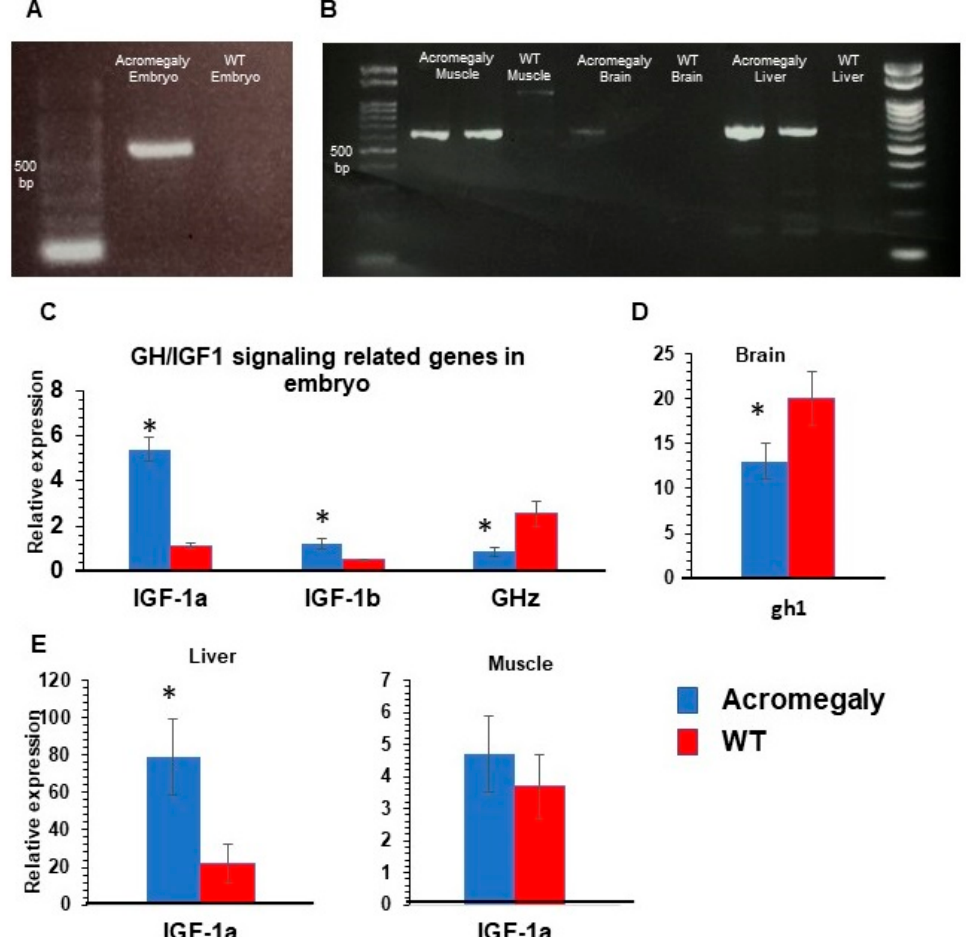
Figure 2. GH/IGF1 signaling ‐ related gene expression in Acromegaly zebrafish. ( A , B ) RT ‐ PCR showing tilapia GH gene expression in acromegaly zebrafish larvae (3 dpf) ( A ), acromegaly muscle, and acromegaly liver ( ‐ year ‐ old), ( B ) but not in wild ‐ type (WT). ( C – E ) Relative gene expression of GH/IGF1 signaling pathway ‐ related genes from acromegaly zebrafish at larval stage (3 dpf) ( C ), one ‐ year ‐ old acromegaly Brain ( D ), and acromegaly muscle and liver ( E ), versus wild ‐ type (WT). IGF1a (insulin ‐ like growth factor 1), IGF1b (insulin ‐ like growth factor 3), and GHz (zebrafish growth hormone). Data are expressed as the mean ± SE ( n = 6). Statistical differences ( t ‐ test, P < 0.05) are denoted by asterisks. dpf: days post ‐ fertilization, mpf: months post ‐ fertilization.